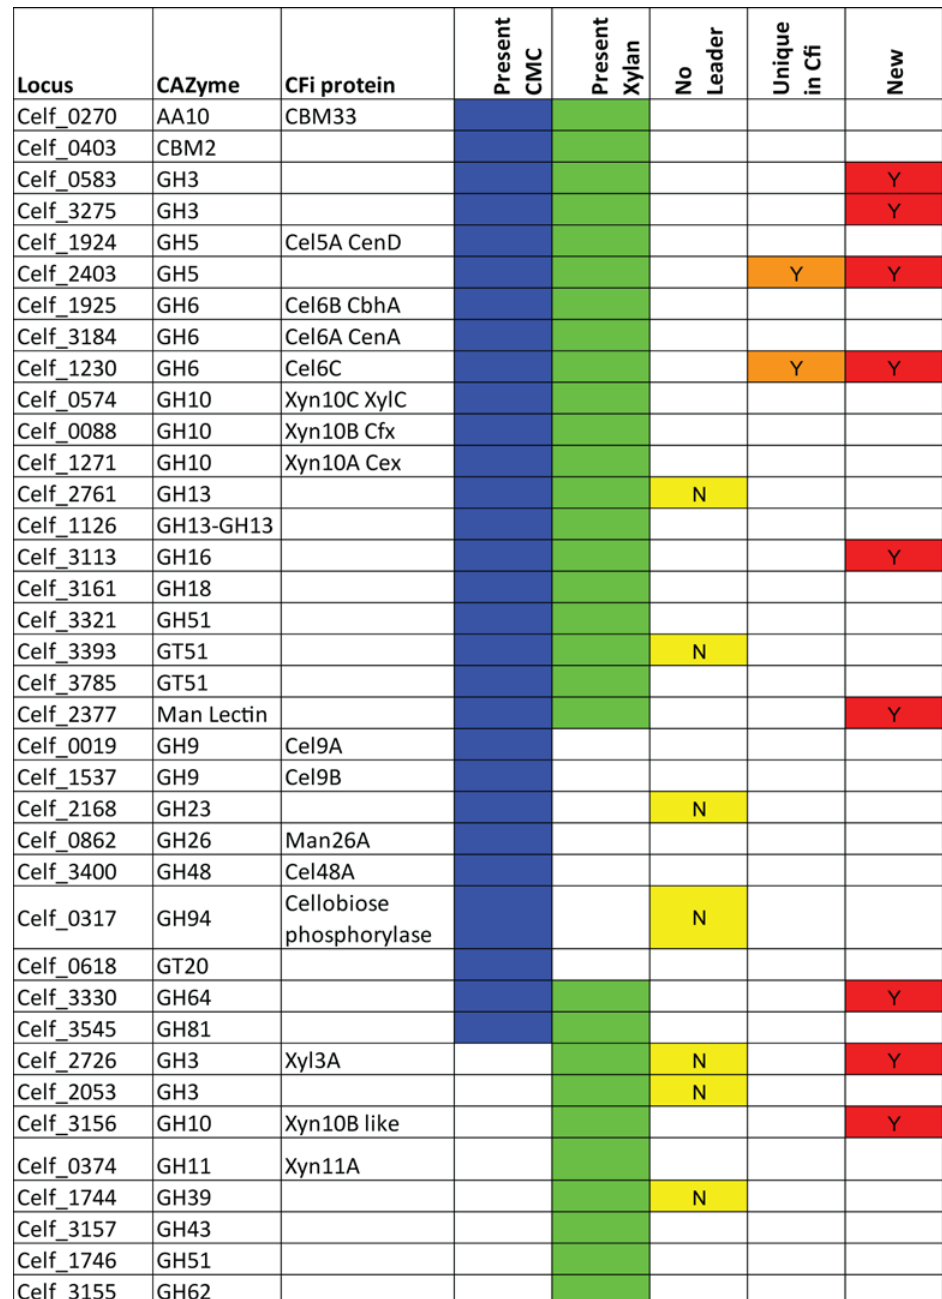
Fig 2. CAZyme content from C . fimi culture supernatants. The proteins are identified by CAZy family, and if they have been previously characterized, the designation is given in CFi protein column. The proteins expressed in media with CMC are indicated with a blue box or those from media with xylan with a green box. The yellow box identifies proteins that have no bioinformatically identified secretion leader (SEC or TAT). The tan box indicates this protein is unique to C . fimi , and the red box identifies a new cellulase or xylanase. The data are arranged by enzyme family for each group: both substrates, CMC only, followed by Xylan only.